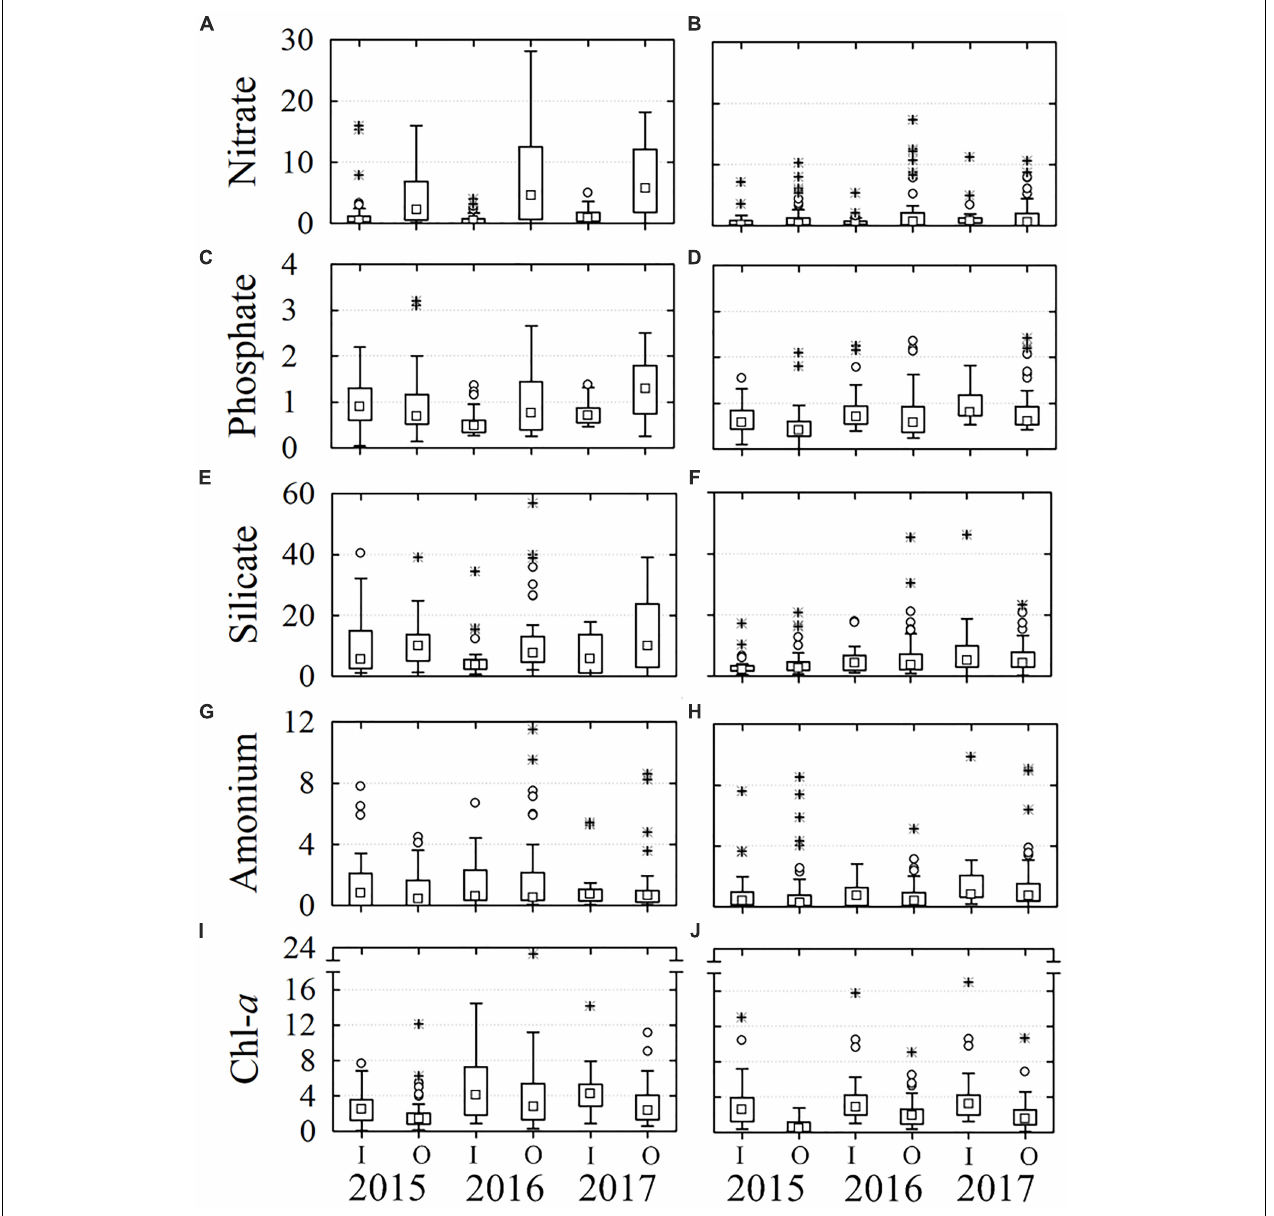
FIGURE 5 | Box and whiskers graphs of nutrients and chlorophyll- a, recorded in the inner (I) and outer (O) stations. Boxes include percentiles 25th, 50th, and 75th; outliers, ∗ extreme values. The panels (A,C,E,G,I) correspond to the first semester and (B,D,F,H,J) to the second one of each year. Inner stations: 1, 2, 9; outer stations: 6, (cid:35)